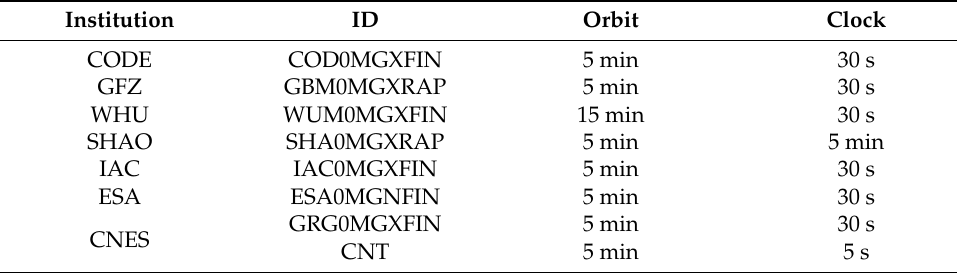
Figure 2. Geographical distribution of 18 MGEX tracking stations. Table 2. Galileo precise satellite products from different